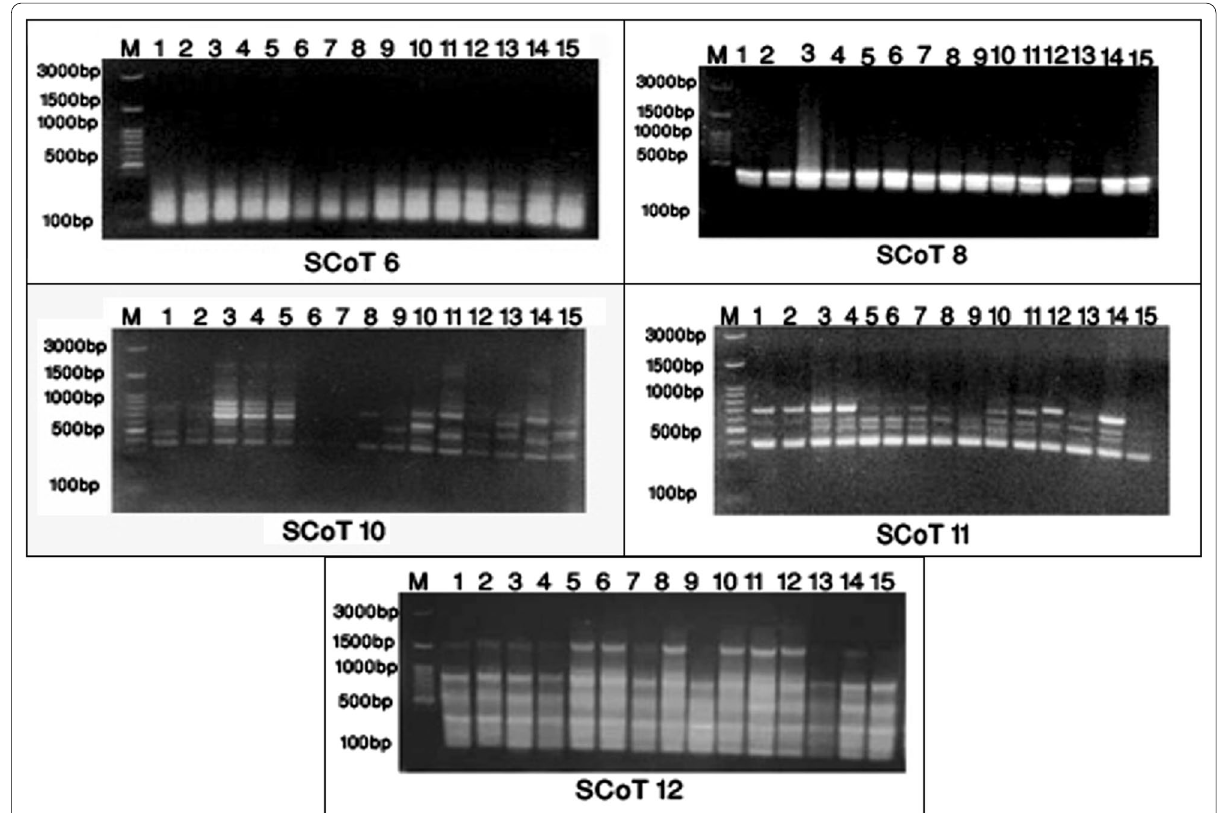
Fig. 1 Amplification profiles of the fifteen Euphorbia species with SCoT markers